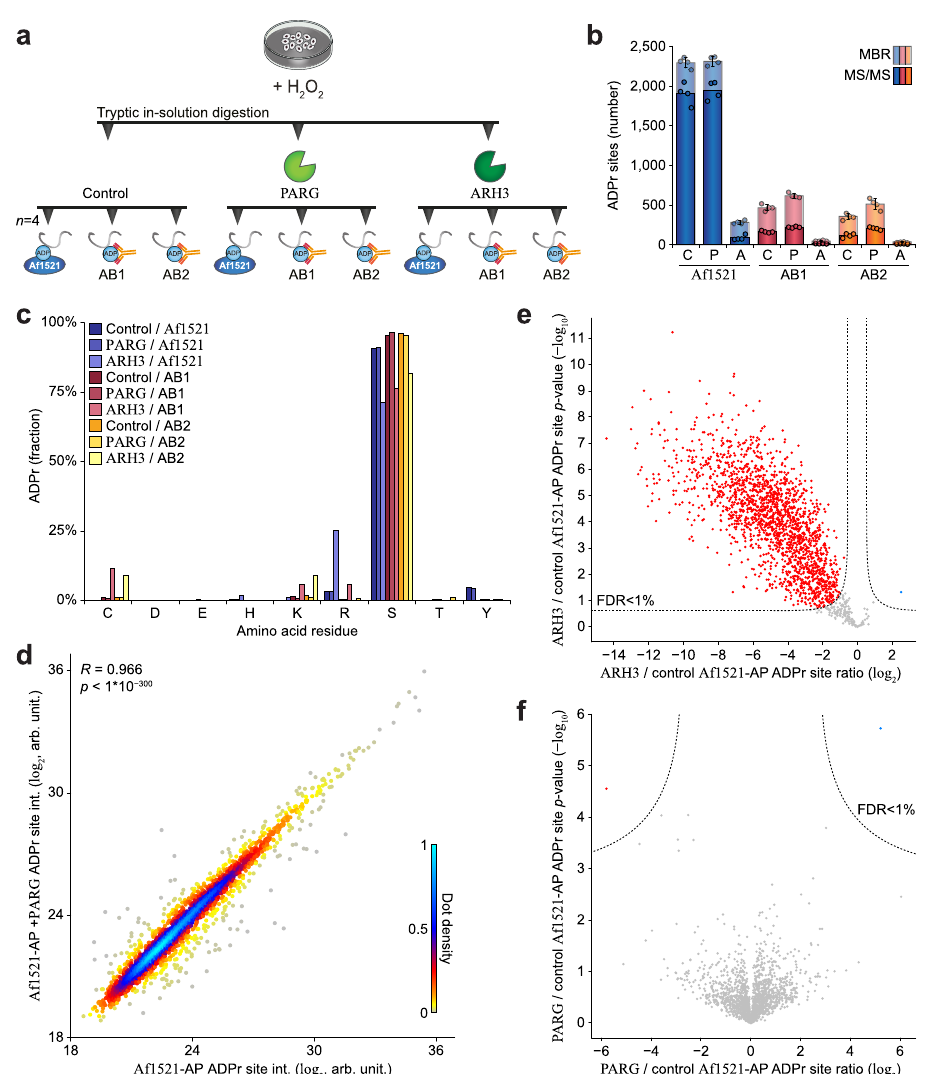
Fig. 2 Evaluation of different erasers and enrichers for the puri fi cation of ADPr. a Overview of the experimental design. HeLa cells were cultured, H 2 O 2 - treated at 1 mM for 10 min, lysed, and either mock treated, PARG-treated, or ARH3-treated. Quadruplicate ( n = 4) ADPr peptide puri fi cations were performed using either Af1521 macrodomain, E6F6A antibody (AB1), or D9P7Z antibody (AB2). ADPr peptides were analyzed using ETD-based high- resolution MS. b Overview of the number of ADPr sites identi fi ed and localized (>90% probability). Data are presented as mean values ± SD, n = 4 puri fi cation replicates. “ C ” ; control, “ P ” ; PARG, “ A ” ; ARH3, “ MBR ” ; matching between runs. c Visualization of the abundance fraction of ADPr as distributed across different amino acid residue types. d Scatter plot analysis demonstrating the correlation between mock-treated and PARG-treated ADPr sites. “ R ” indicates Pearson correlation, p -value determined via linear regression t test. e Volcano plot analysis comparing ARH3-treated versus mock-treated Af1521- enriched ADPr sites. Red and blue dots indicate signi fi cantly down- and upregulated sites, respectively. Signi fi cance was determined via two-tailed Student ’ s t testing, with permutation-based FDR-control applied with an s0 fuzz factor of 0.5 and 2500 rounds of randomization, to ensure a corrected p -value of <1%. f As e , but comparing PARG-treated versus mock-treated Af1521-enriched ADPr sites. Source data are provided as a Source Data fi